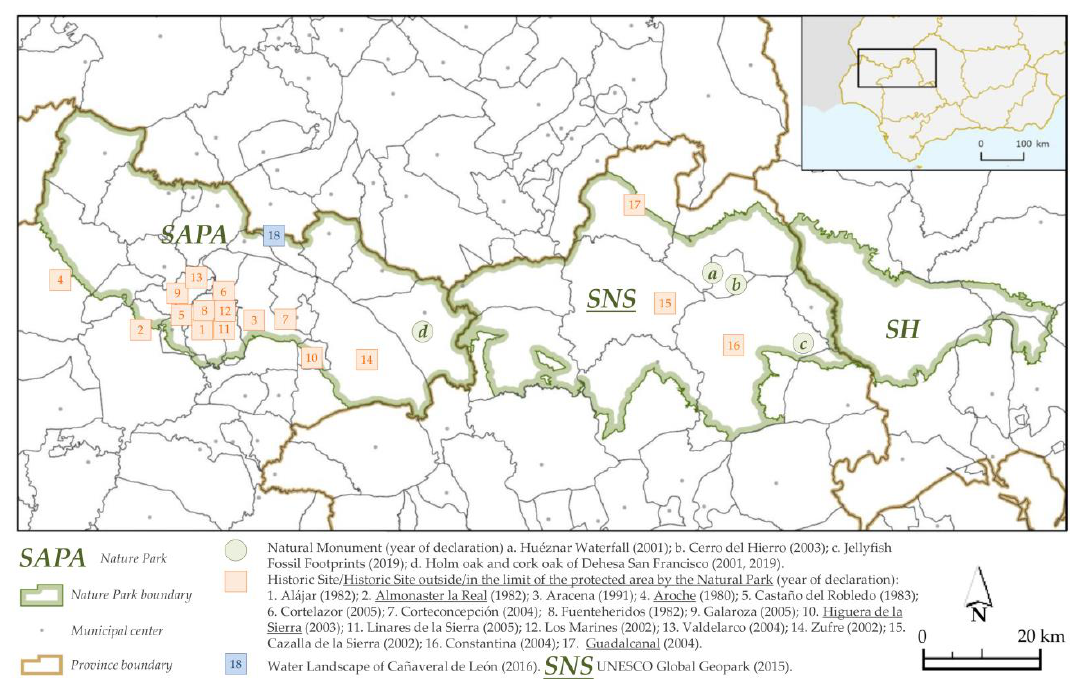
Figure 2. Scope of the study. Source: [87,88]; authors’ elaboration.